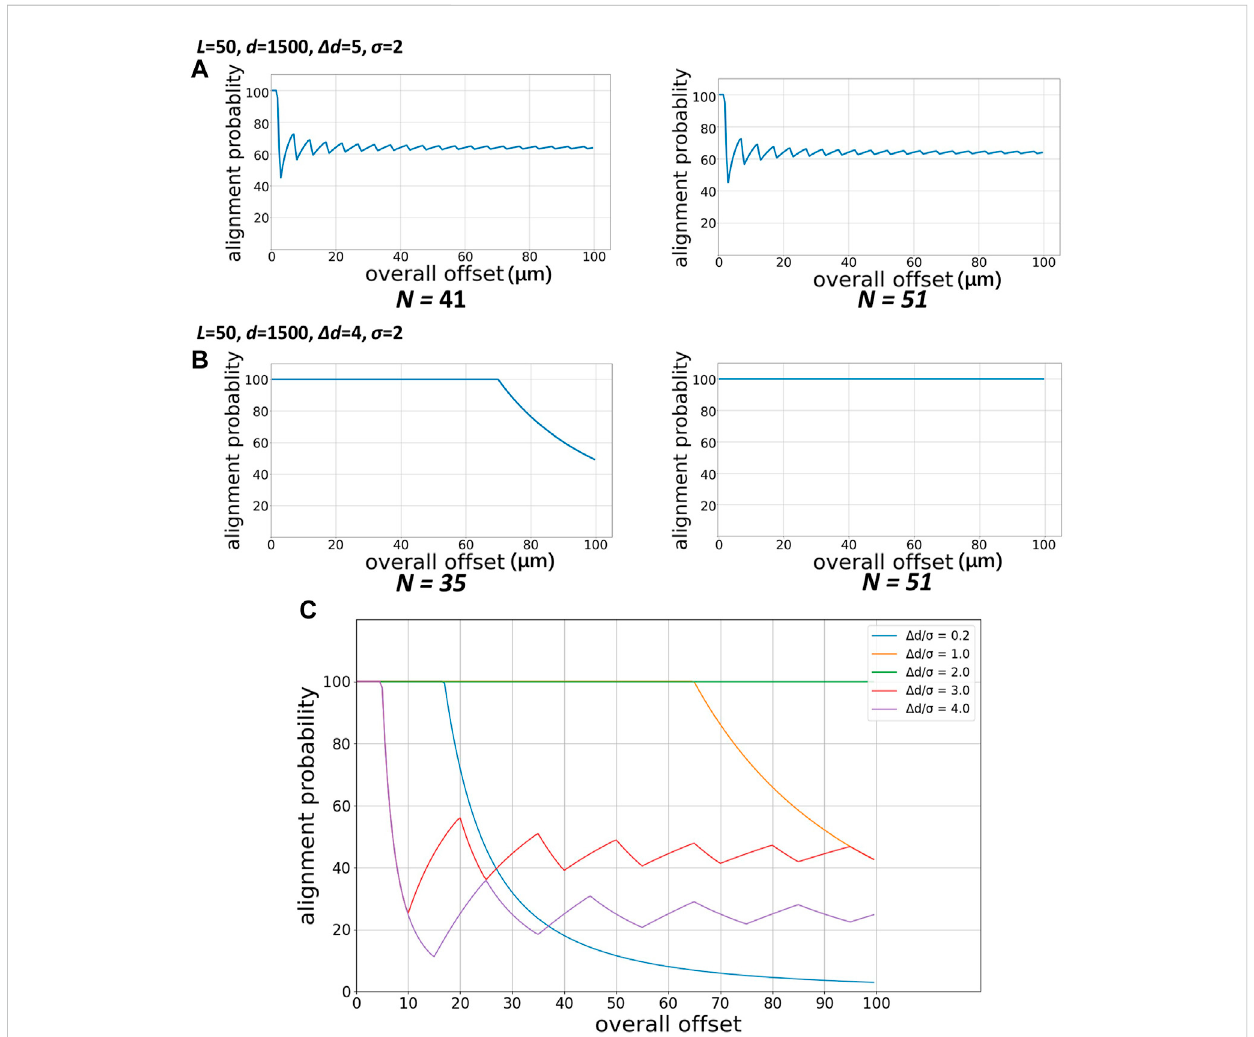
FIGURE 4 Probability of successful alignment varied with overall offset with different Δ d and different N. (A) Δ d = 5 µm (B) Δ d = 4 µm (C) Probability of successful alignment of a matrix with the same parameters under different Δ d